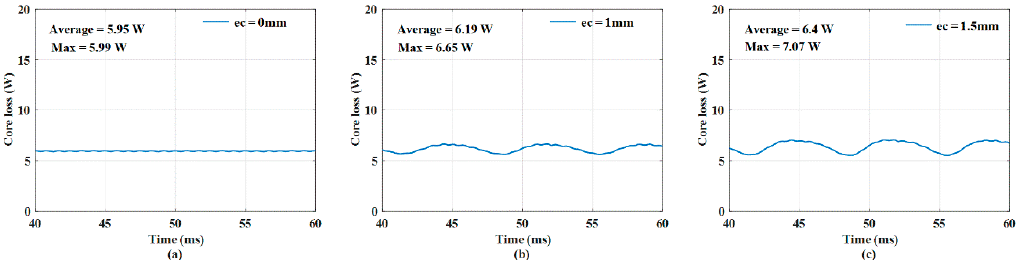
Figure 9. Core loss when fundamental current was applied: ( a ) ec = 0 mm, ( b ) ec = 1 mm, and ( c ) ec = 1.5 mm.